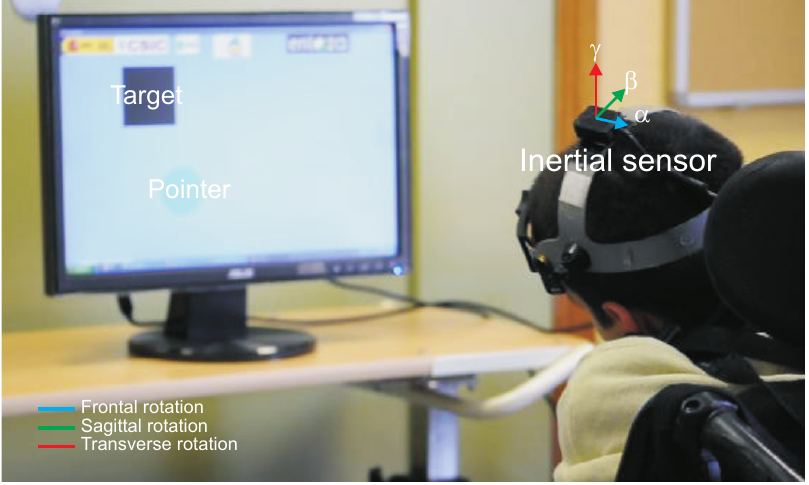
Figure 1. Experiments with the inertial interface at Cantabria ASPACE